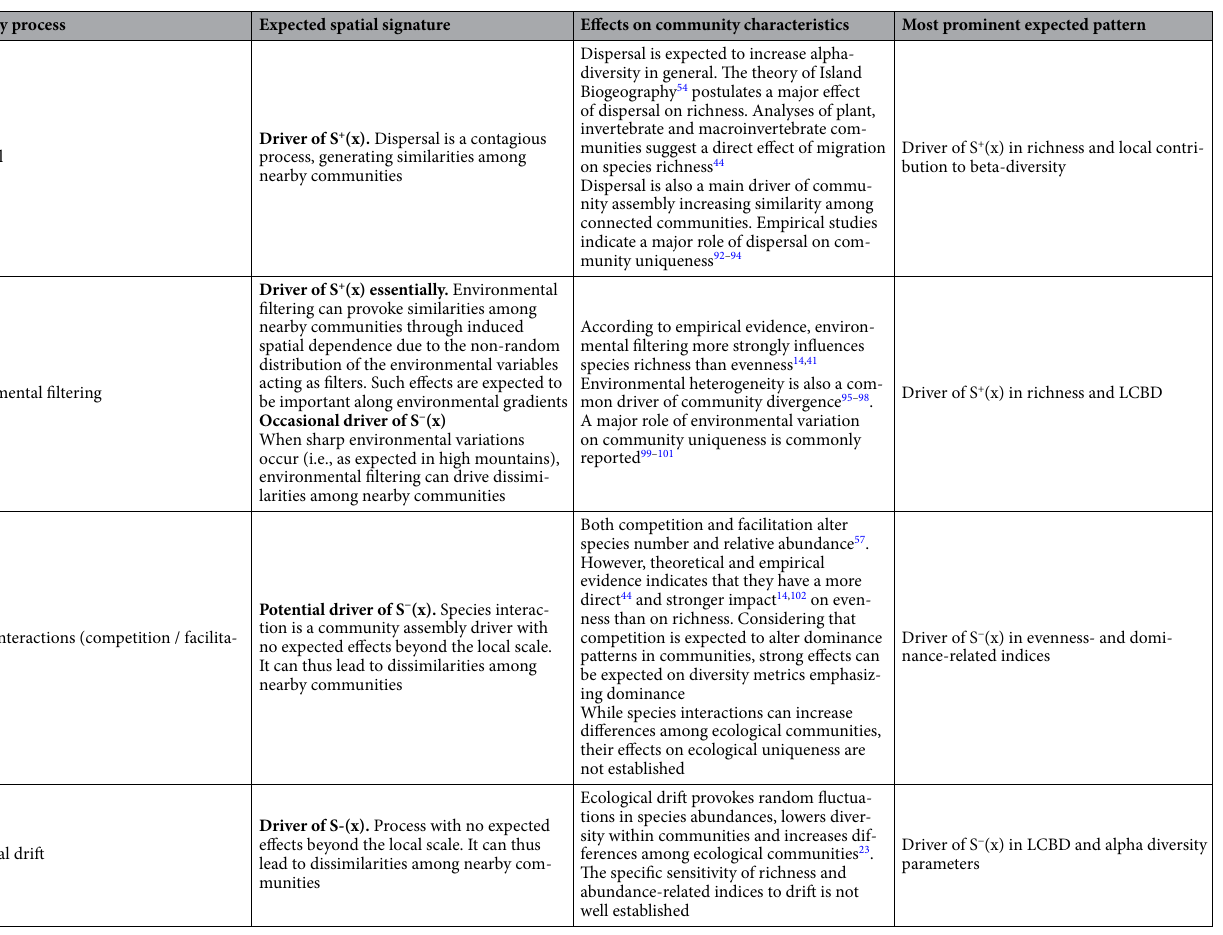
Table 1. Expected spatial signatures of community assembly processes on different community characteristics. S + (x): positive spatial autocorrelation, S − (x): negative spatial